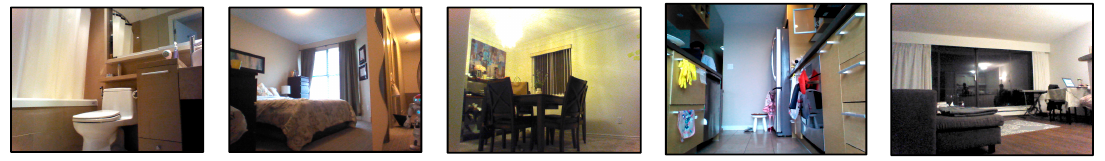
Figure 6. Scenes examples taken by NAO humanoid robot.